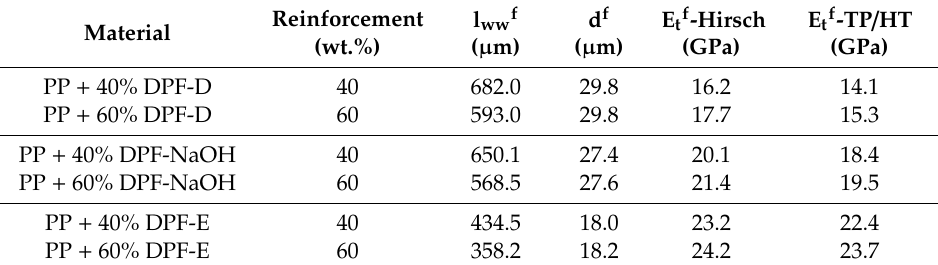
Table 3. Intrinsic Young’s modulus of DPF in PP composites and main morphological characteristics.